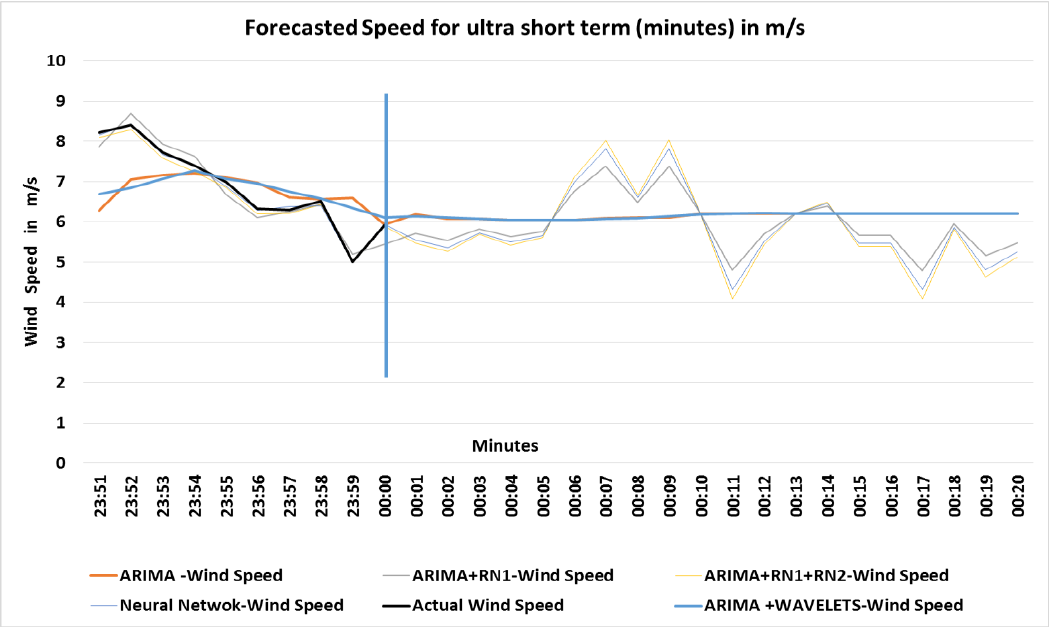
Figure 8. Estimated speed ultra-short term (minutes) in m/s.